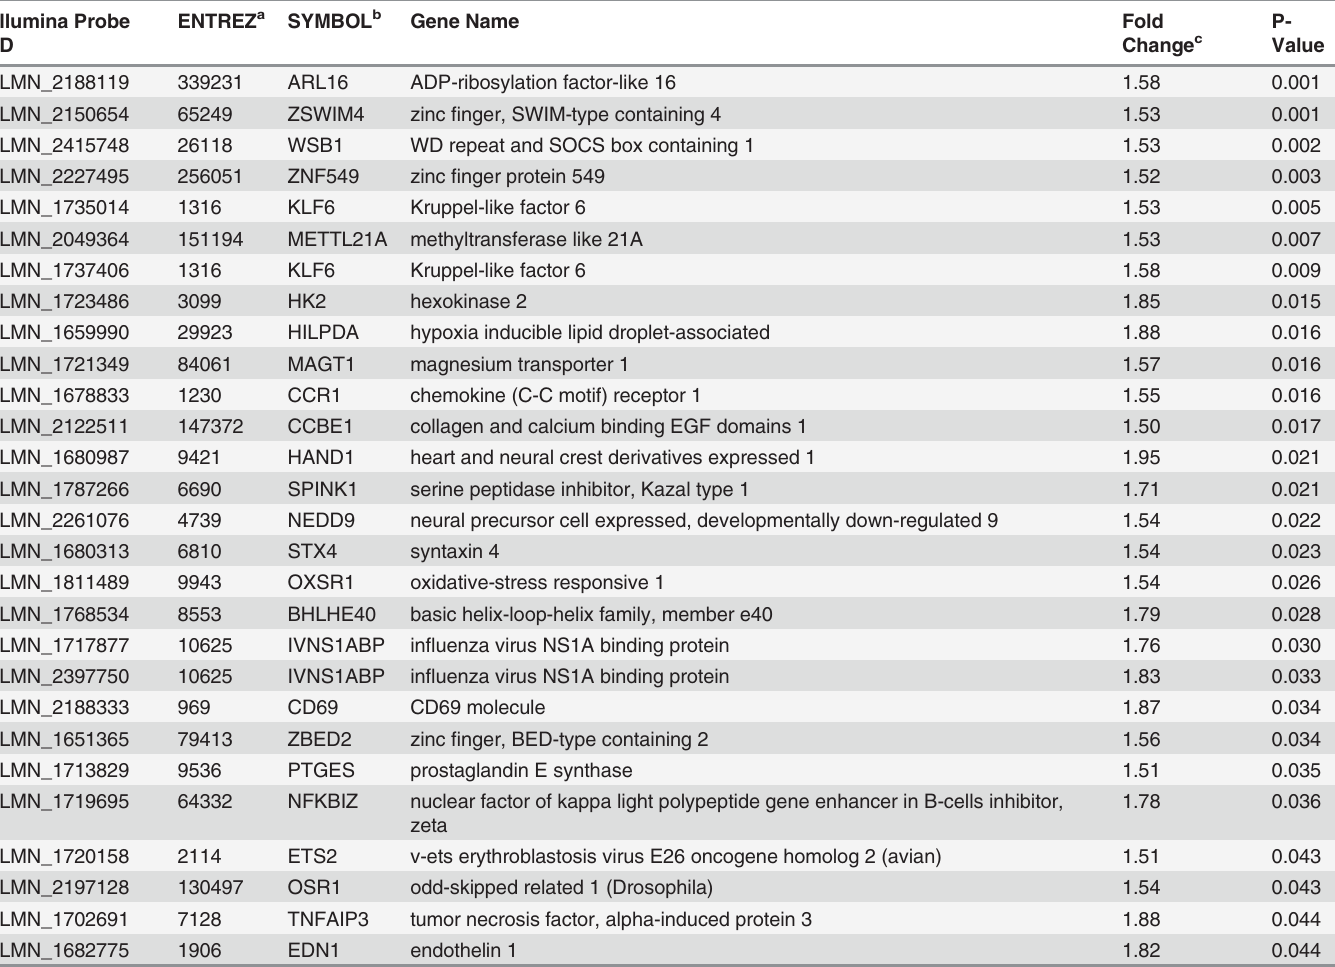
Symbol- taken from the gene database which corresponds to the of fi cial Human Genome Organization Gene Nomenclature Committee symbols c- Fold change (the number of times the average expression level in the chorioamniotic membranes of the neurocognitive impairment group differs from the average expression level in the normal comparison group